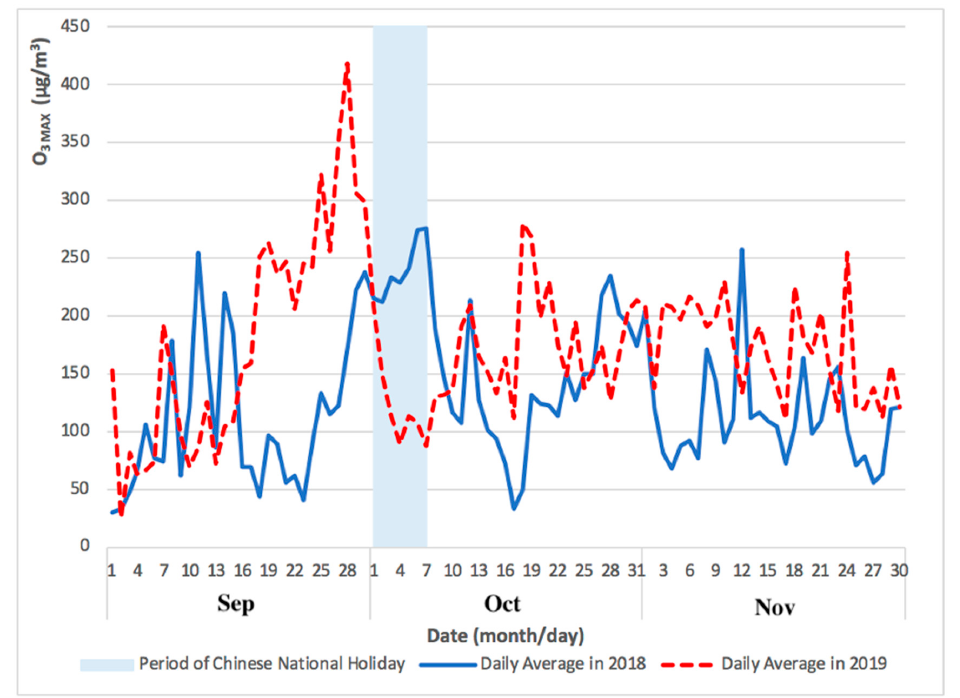
Figure 2. O 3 MAX concentrations for Taipa Ambient highlighting a pollution episode immediately